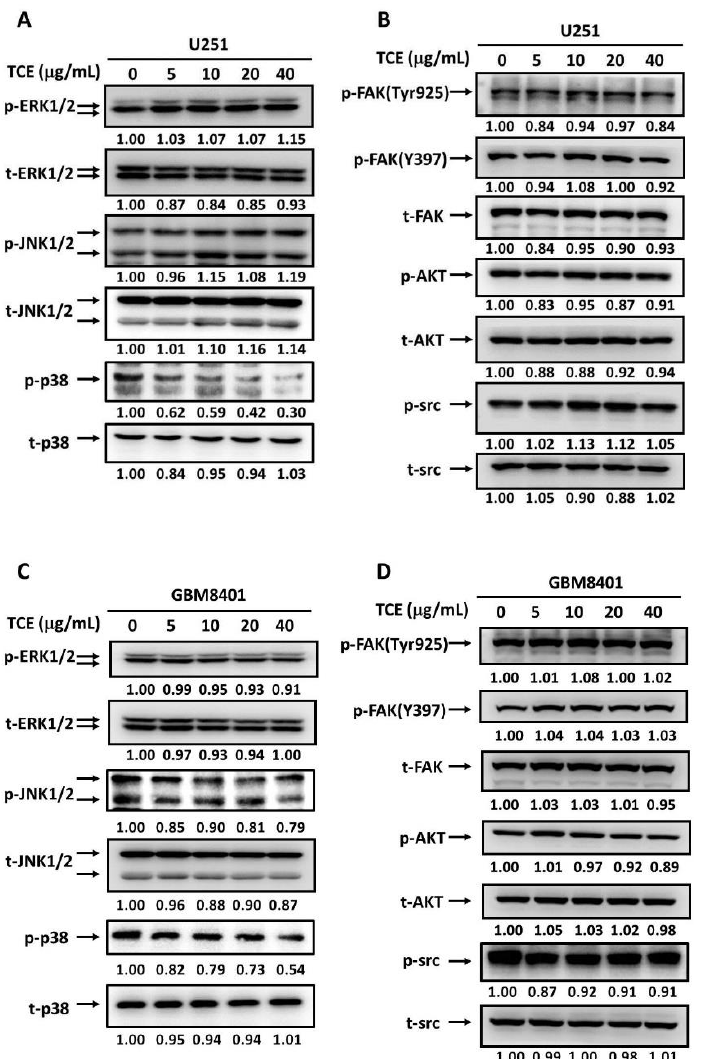
Figure 4. Effects of T. catappa L . extract (TCE) on signaling cascades in U251 and GBM8401 cells. After 6 h culture with various concentrations of TCE (0, 5, 10, 20, and 40 μg/mL), the lysates of U251 and GBM8401 cells were subjected to SDS-PAGE followed by a Western blots assay with ( A , C ) anti-ERK1/2, anti-JNK1/2, anti-p38 and ( B , D ) anti-FAK, anti-AKT, anti-Src (total and phosphorylated) antibodies.